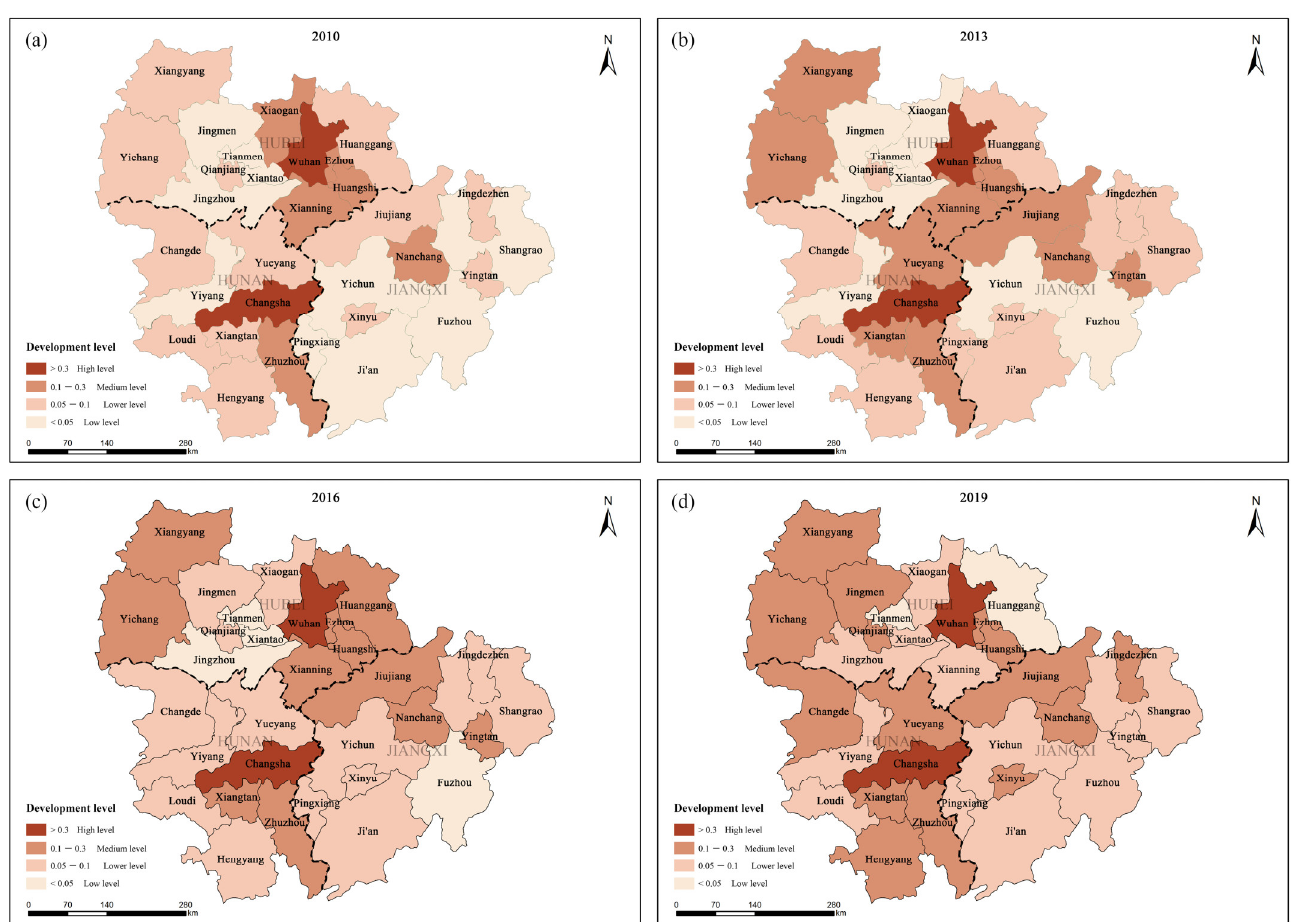
Figure 6. The space–time changes of the comprehensive evaluation level of HQED from: ( a ) 2010; ( b ) 2013; ( c ) 2016; ( d ) 2019.